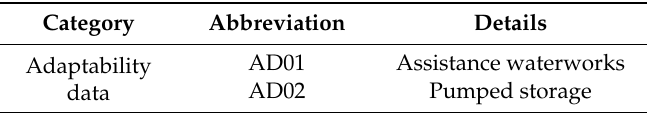
Table 4. Adaptability data details and